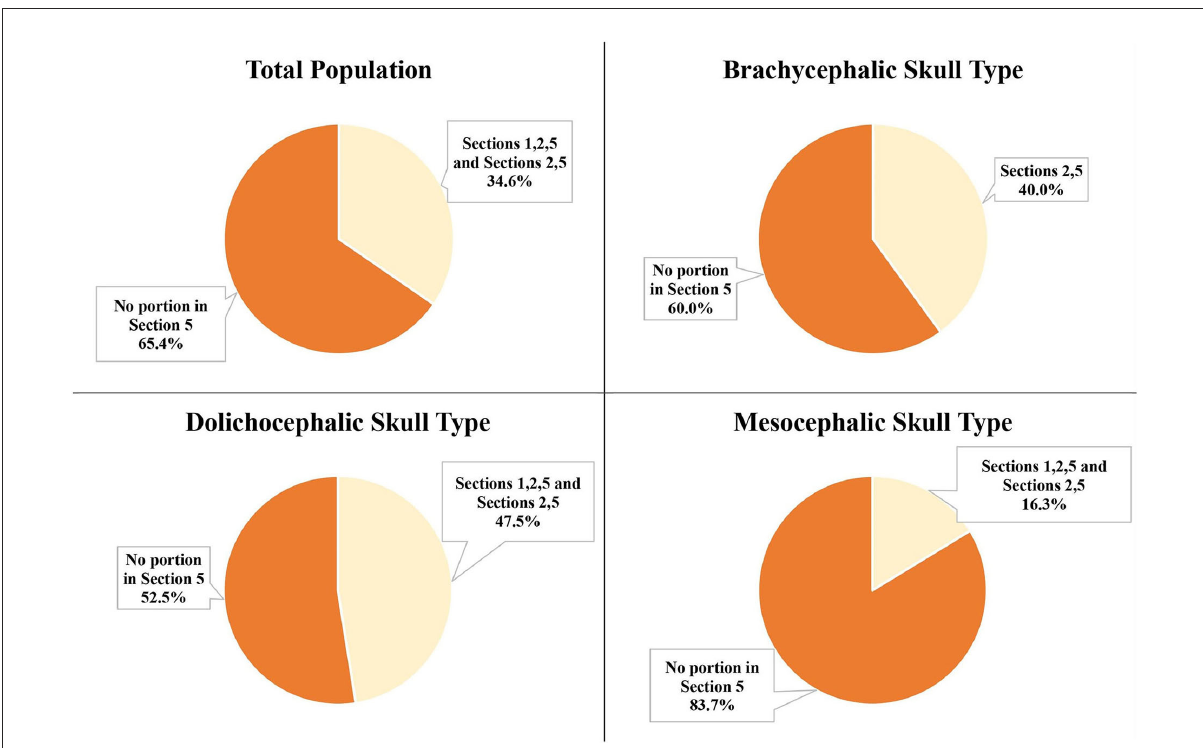
FIGURE8 IOC fully or partially in Section 5 at the mesial roots of the P4 for the total population and the three different skull